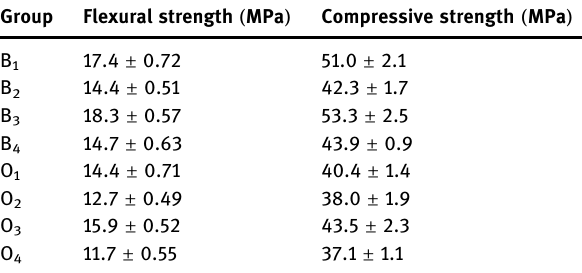
Figure 2: Schematic diagram of microhardness.